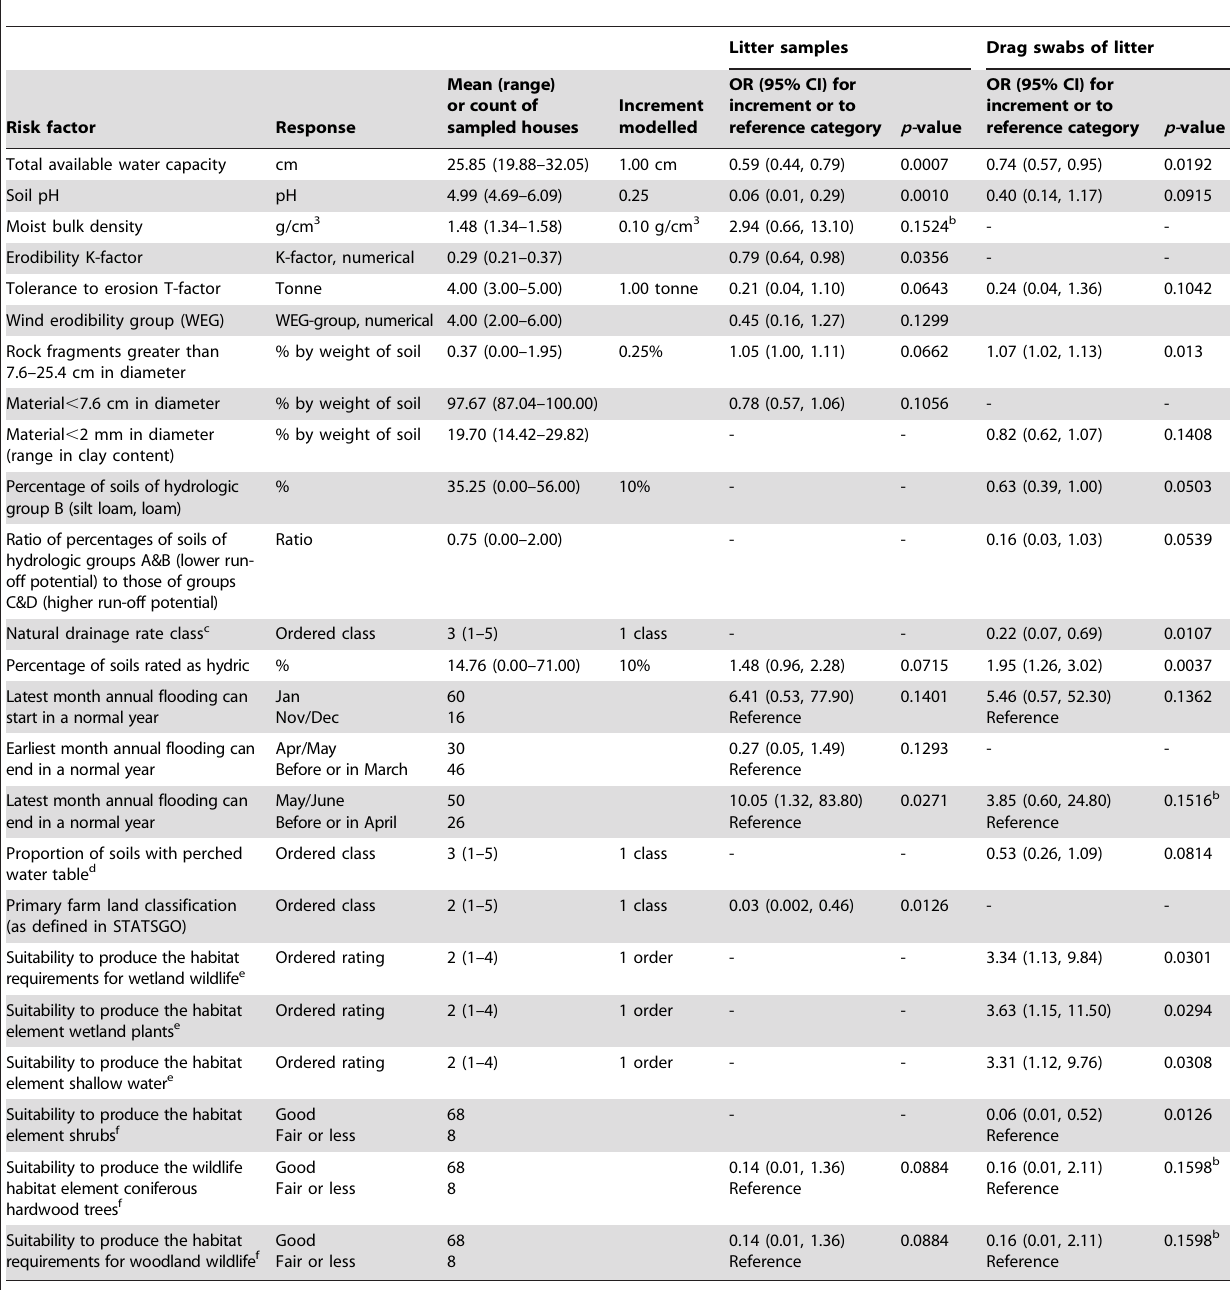
Table 1. Soil properties at broiler grow-out farm location associated with probabilities of detecting Salmonella in the samples and drags swabs of litter in screening analyses (n= 76) a